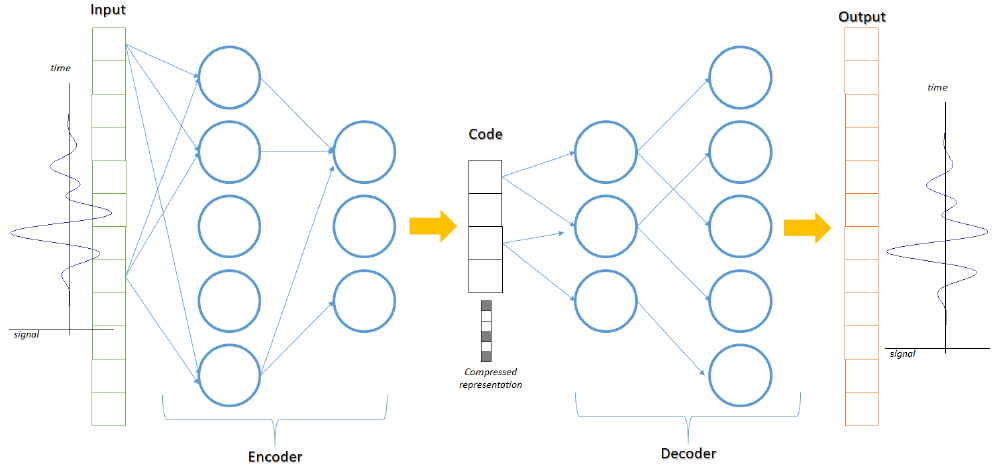
Figure 3. The use of an auto-encoder for data reduction and information